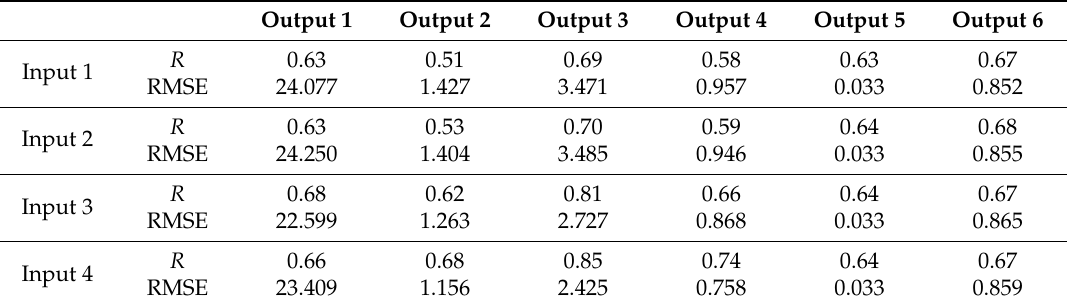
Table 4. Results for the CART model. Best results are displayed in bold.